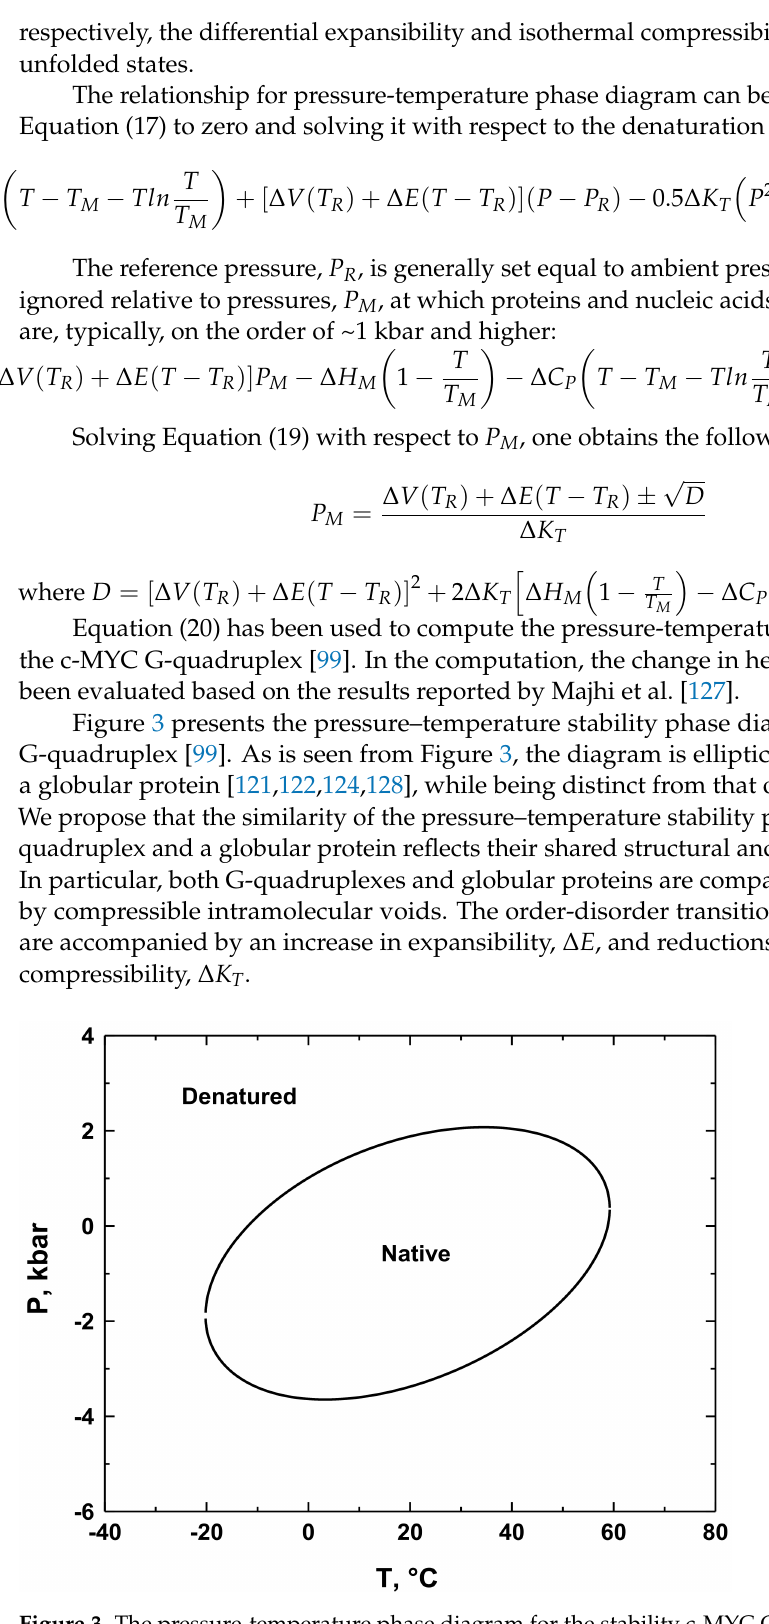
Figure 3. The pressure-temperature phase diagram for the stability c-MYC G-quadruplex at 50 mM CsCl and 0.1 mM KCl computed with Equation (20) from ref.